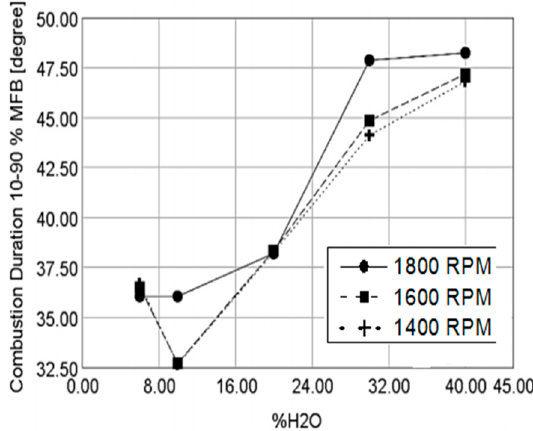
Figure 5. Effect of increased water content in ethanol on combustion duration (10%–90% of mass fraction burned) Reprinted with permission from Reference [76]. Copyright (2015) SAE fraction burned) Reprinted with permission from Ref. [76]. Copyright (2015) SAE International.